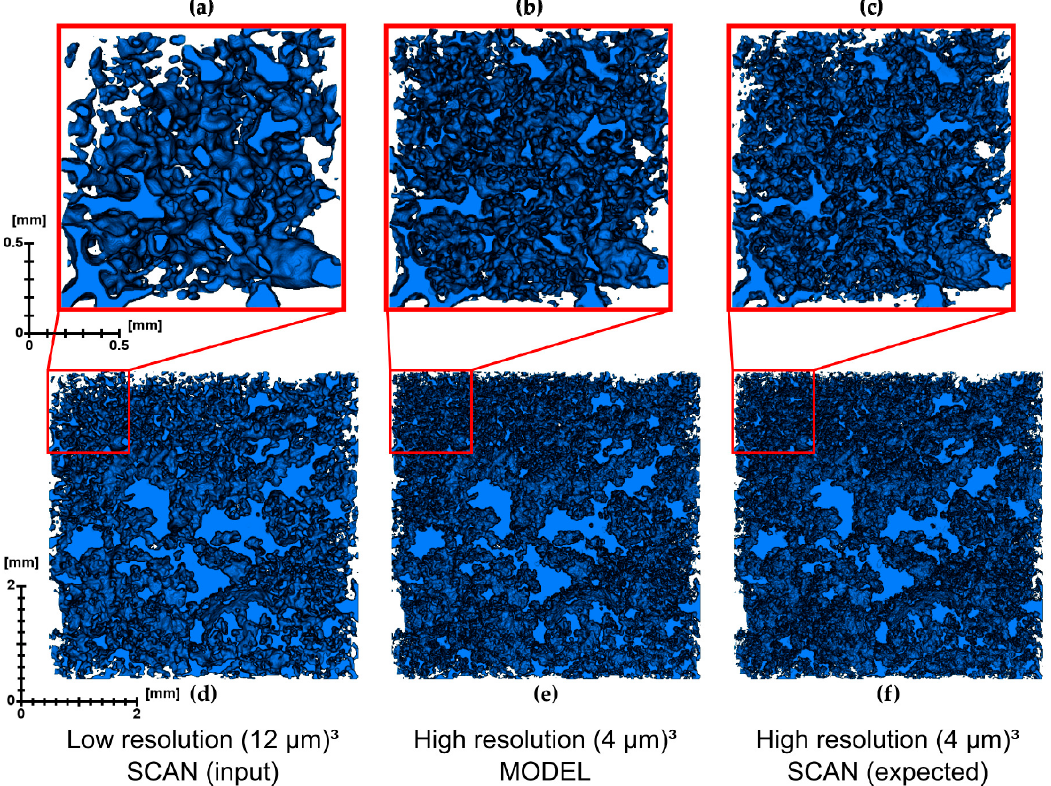
Figure 5. Three-dimensional volumes comparing LR input ( a , d ) to the super-resolved model (SRM— b , e ) and the expected HR volume ( c , f ). The LR volume gives the impression of containing less pores and smoother pore edges. SRM appears to have more pores and more complex pore boundaries, compared to the LR input, although it does not yet fully equate to the expected HR. However, visually SRM is more closely resembling HR than LR.